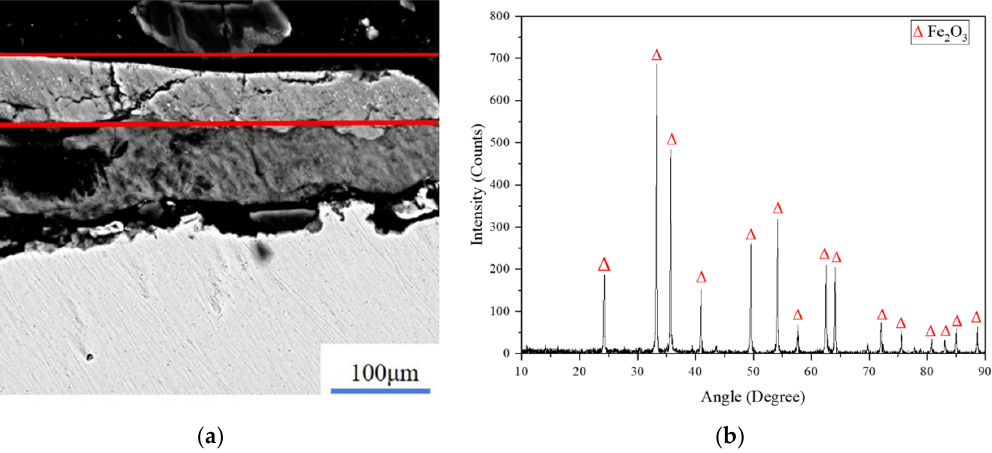
Figure 1. The layered structure distribution of Fe 2 O 3 and X ‐ ray ‐ diffraction analysis. ( a ) Distribution of Fe 2 O 3 ; ( b ) X ‐ ray ‐ diffraction analysis of Fe 2 O 3.